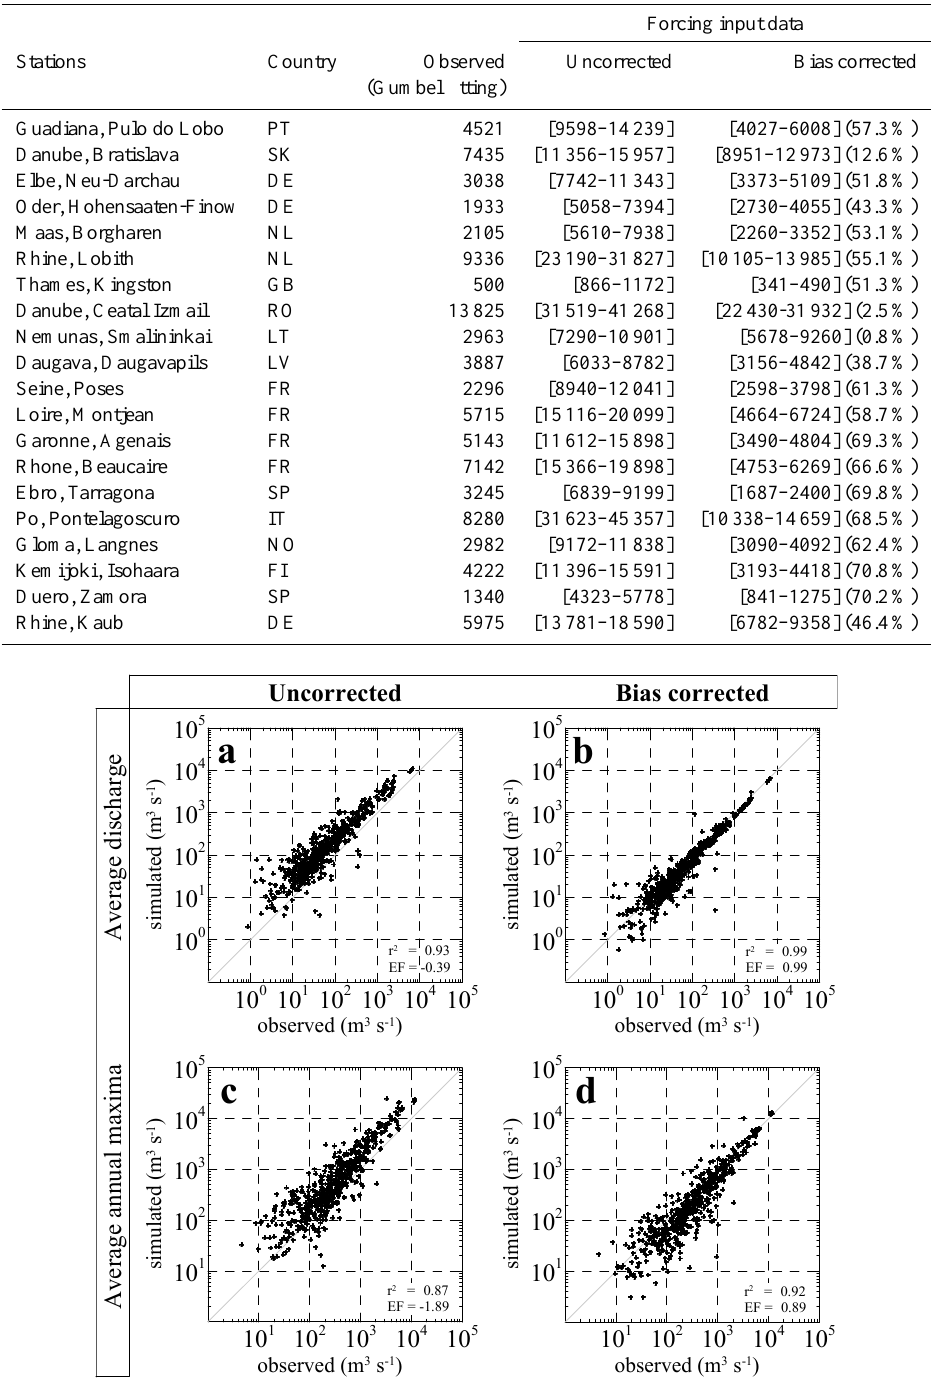
Table 3. 95% confidence intervals obtained using the profile-likelihood method for a return period of 100-yr for the gauging stations depicted in Fig. 1 for the control period 1961–1990. Observed column corresponds to Q 100 obtained from a Gumbel distribution fitted from the observations. All values in m 3 s − 1 (values in parentheses show the percentage reduction).